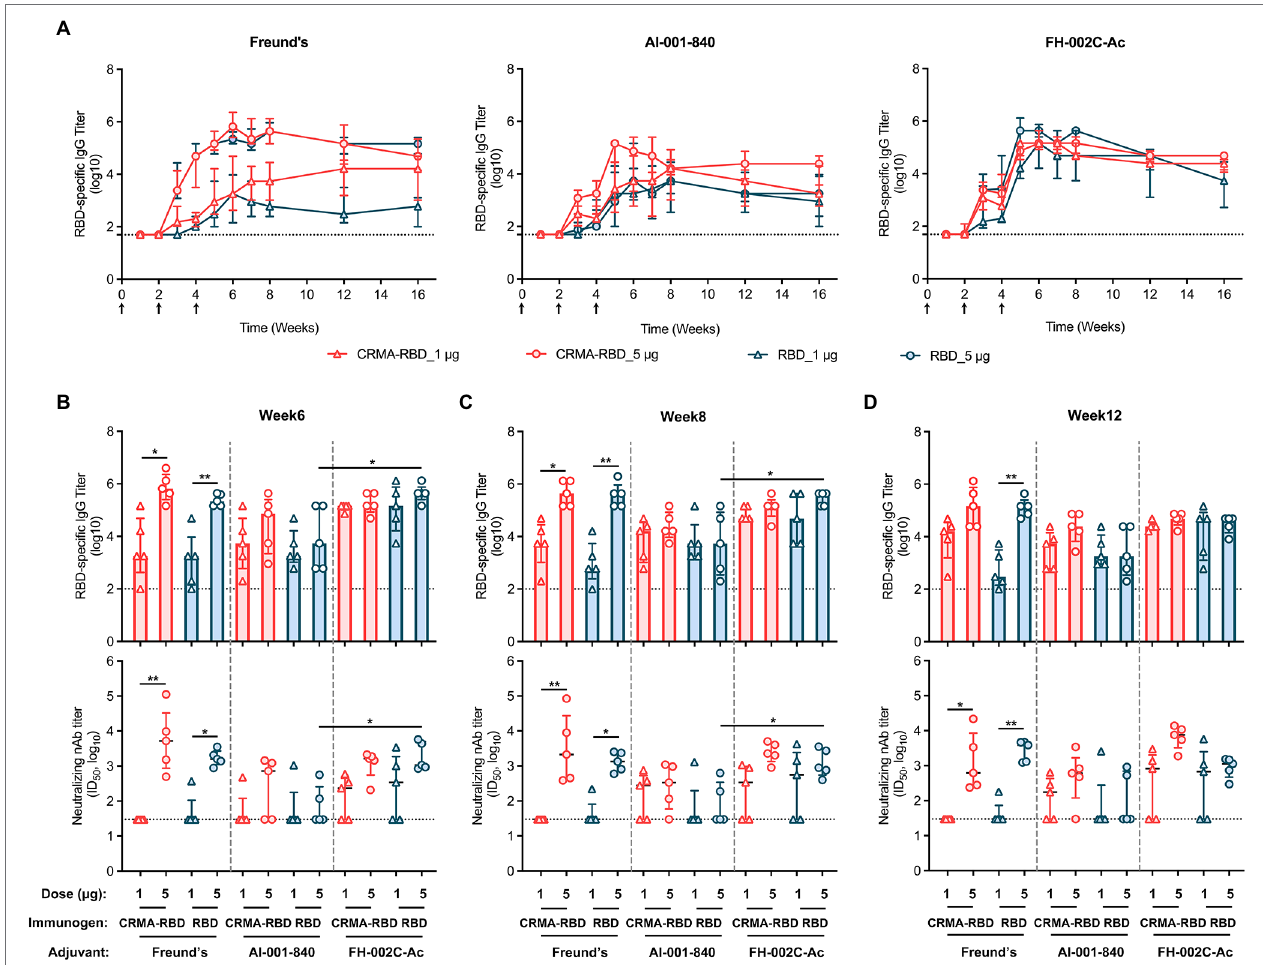
FIGURE 5 | The persistence of recombinant CRMA-RBD-induced humoral immunity in mice. (A) IgG titers of anti-RBD in immunized mice were monitored for up to 16 weeks. Mice ( n = 5) were vaccinated with three doses of CRMA-RBD and RBD antigen formulations. Black arrows indicate the immunization time points. Serum samples were collected at appropriate intervals (weeks 0, 1, 2, 3, 4, 5, 6, 7, 8, 12, and 16) after immunization. (B–D) RBD-specific and neutralizing antibody titers measured at weeks 6, 8, and 12 post-vaccination. Data were plotted as median ± IQR. The statistical significance was determined by a Kruskal–Wallis test with Dunn’s multiple comparisons test. p values: * p < 0.05 and ** p <